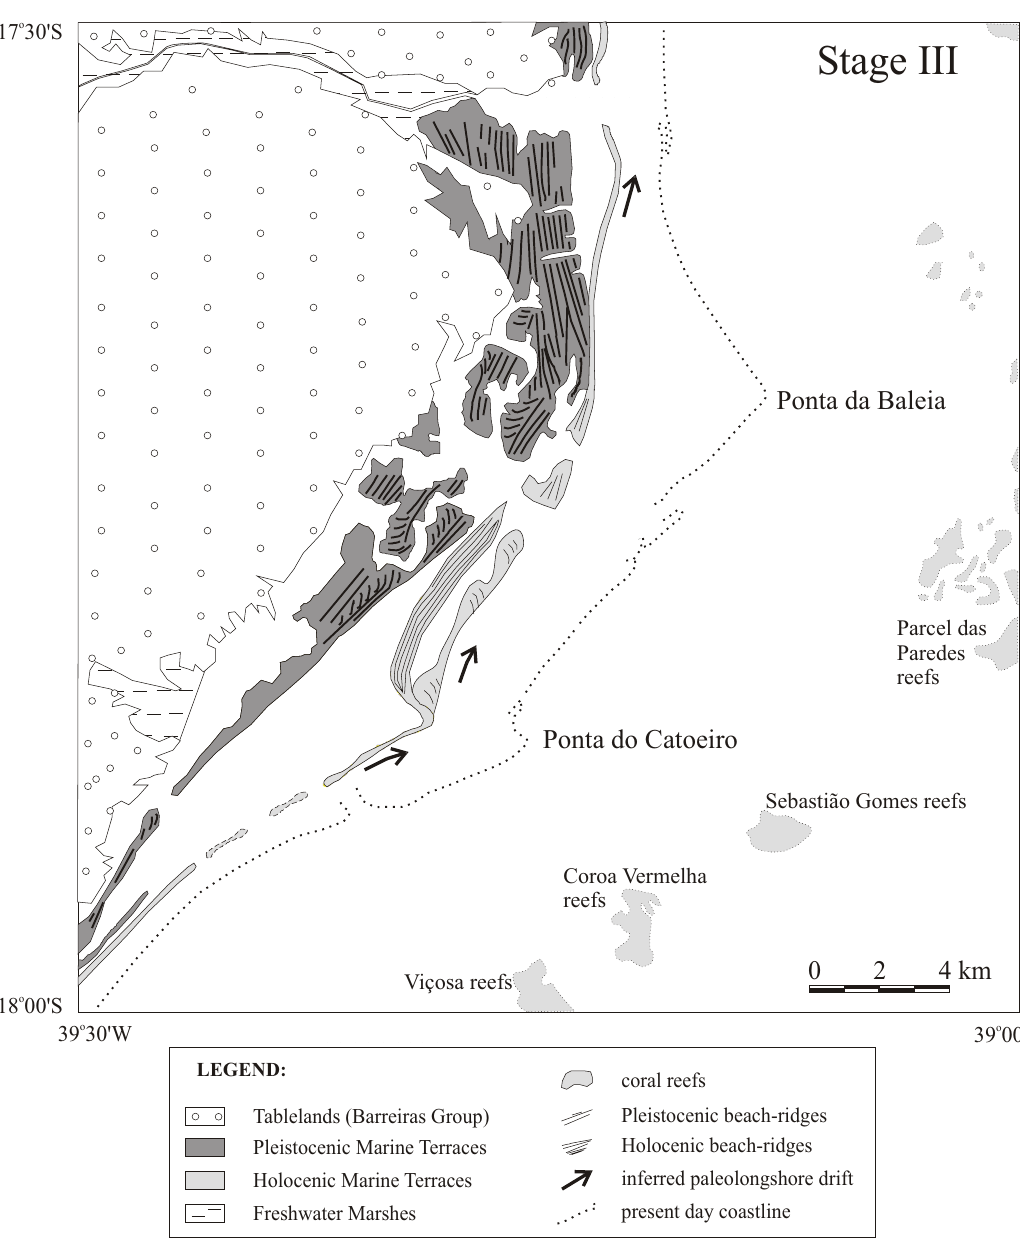
An Acad Bras Cienc (2003) 75